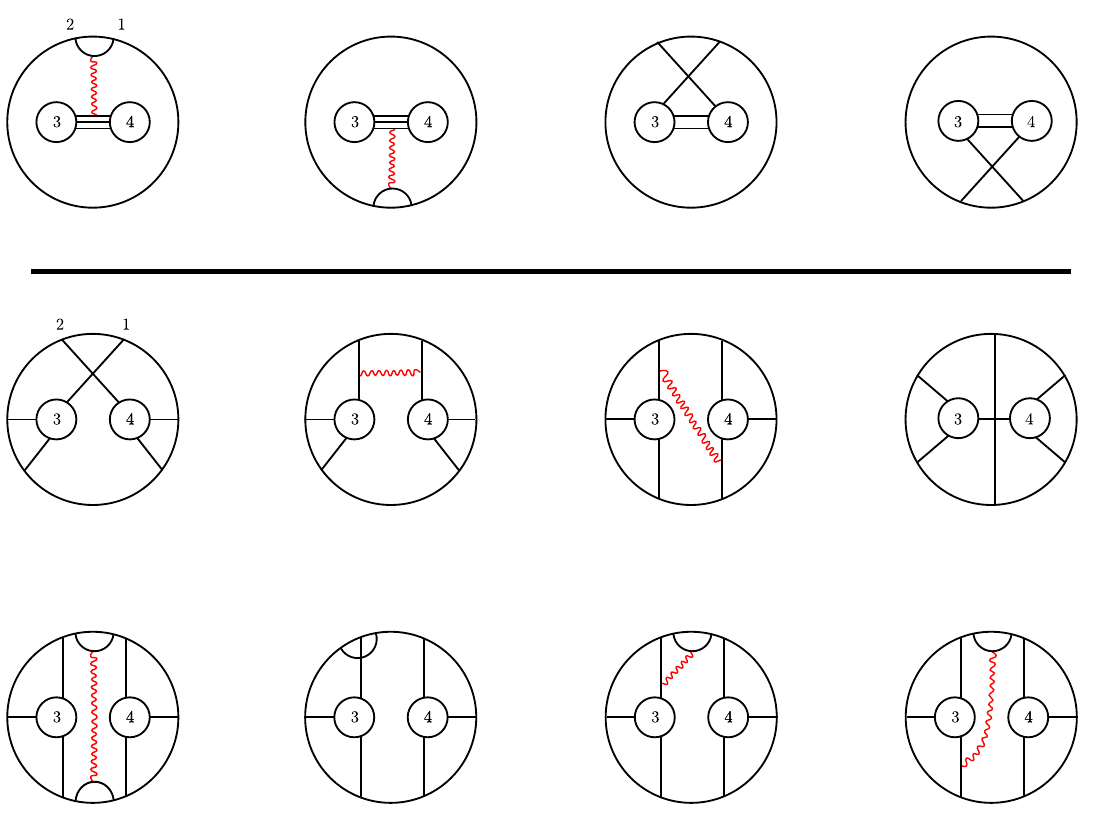
Figure 48 . The diagrams that contribute for L = 0 and 2 p . The (cid:12)rst four diagrams are for L = 0 while the remaining ones are for L = 2 p . For L = 2 p , we omitted drawing diagrams with the same topology; we have only drawn one representative for